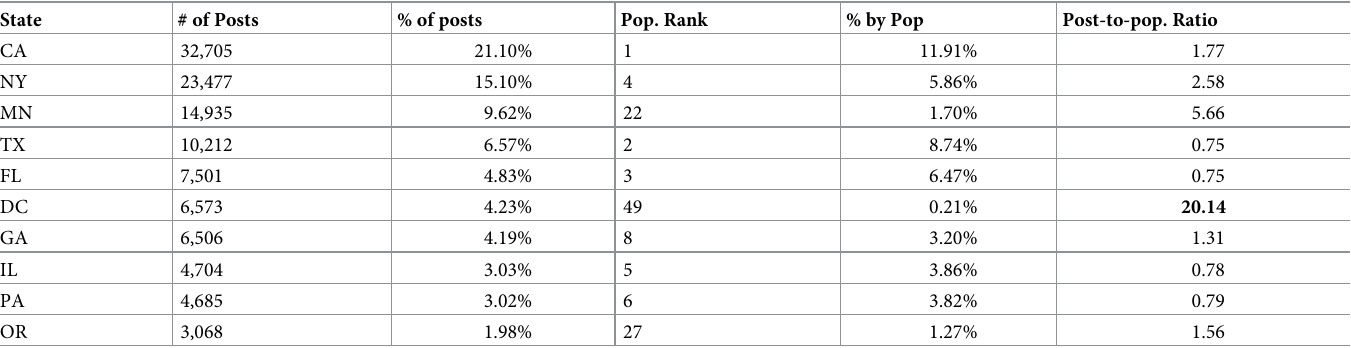
Table 1. Top states by number of posts and comparison with actual population statistics. The percentage by population shows the actual percentage relative to the entire population of the United States. As such, the post-to-pop. ratio describes the level of over-representation a certain state has, with D.C. leading at 20.14 times the